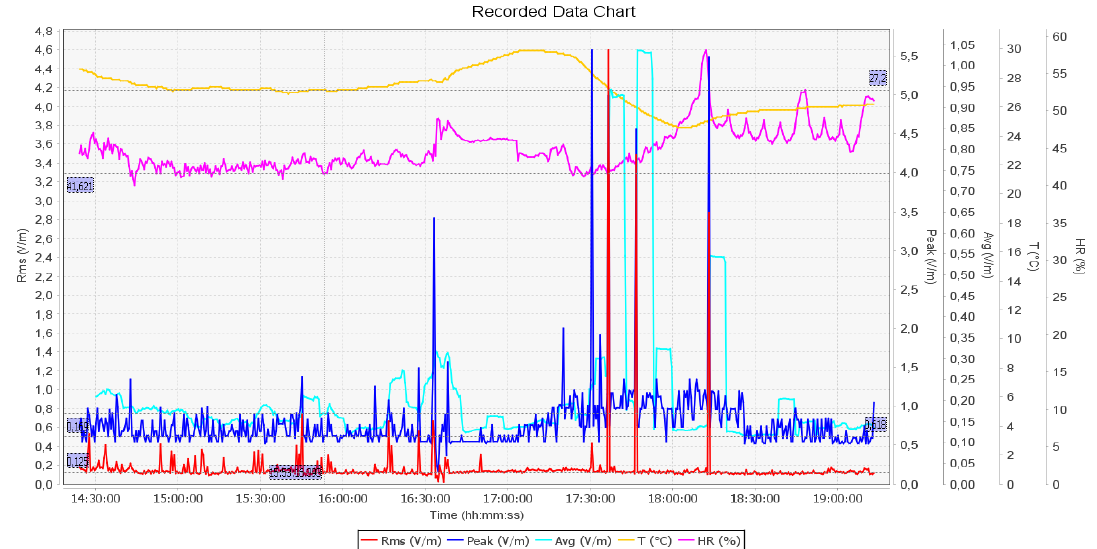
Figure 3. The intensity of the electrical component of the electromagnetic field in the course of flight no. 1 for the Aero AT3.